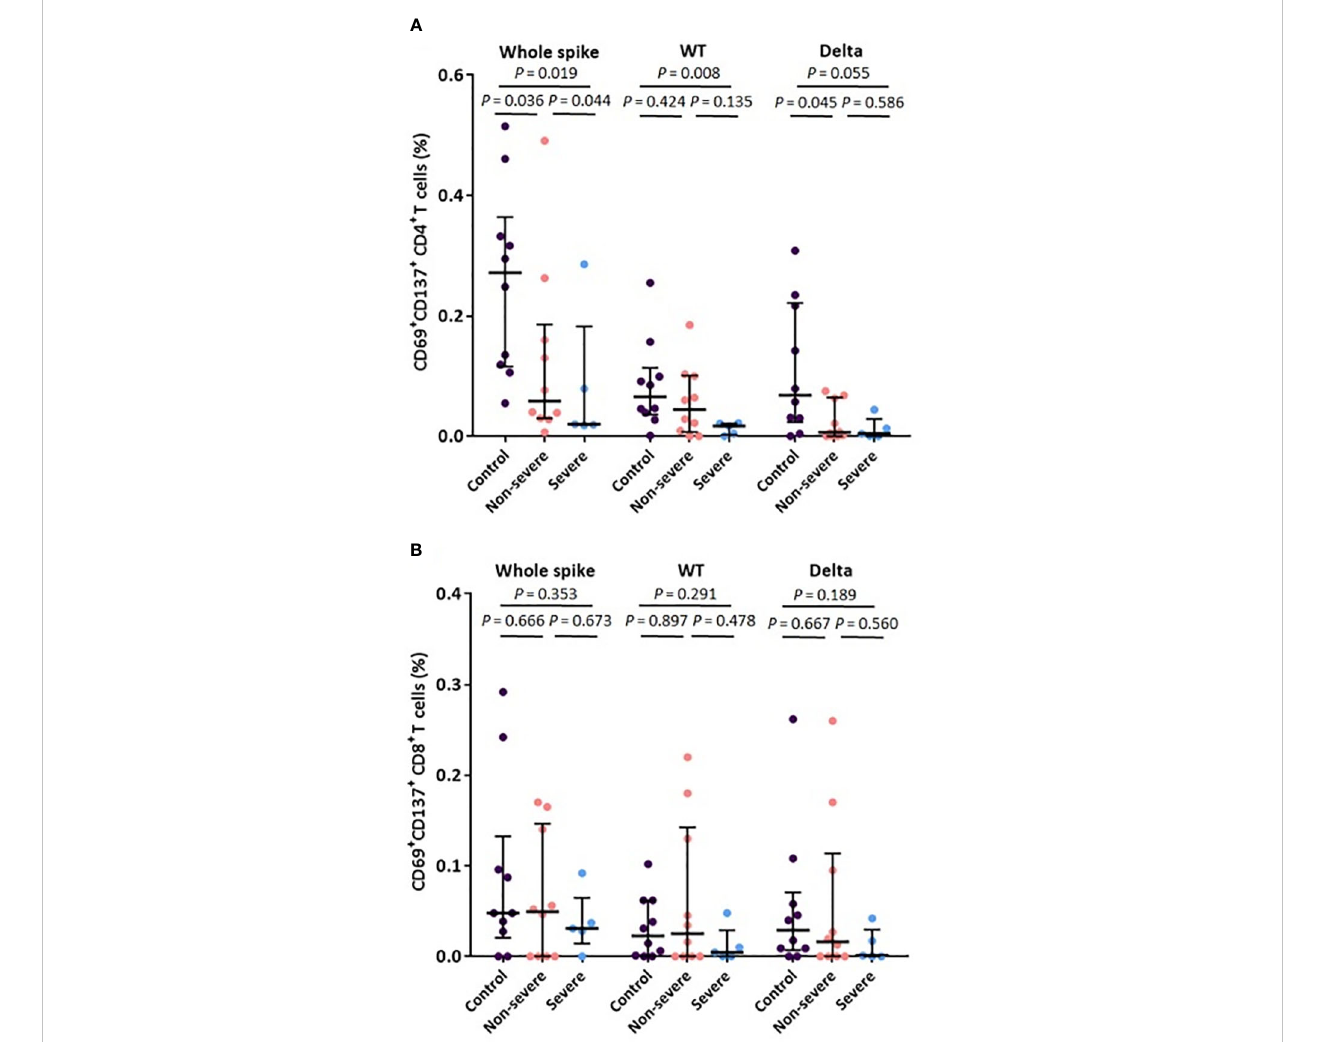
FIGURE 3 T cell responses within 1 week after diagnosis of breakthrough COVID-19. (A) AIM + CD4 + T cells stimulated with the whole spike Ag, and the matched WT and Delta Ags. (B) AIM + CD8 + T cells stimulated with the whole spike Ag, and the matched WT and Delta Ags. The control group denotes vaccinated subjects without breakthrough COVID-19. Vertical and horizontal lines indicate the median with the interquartile